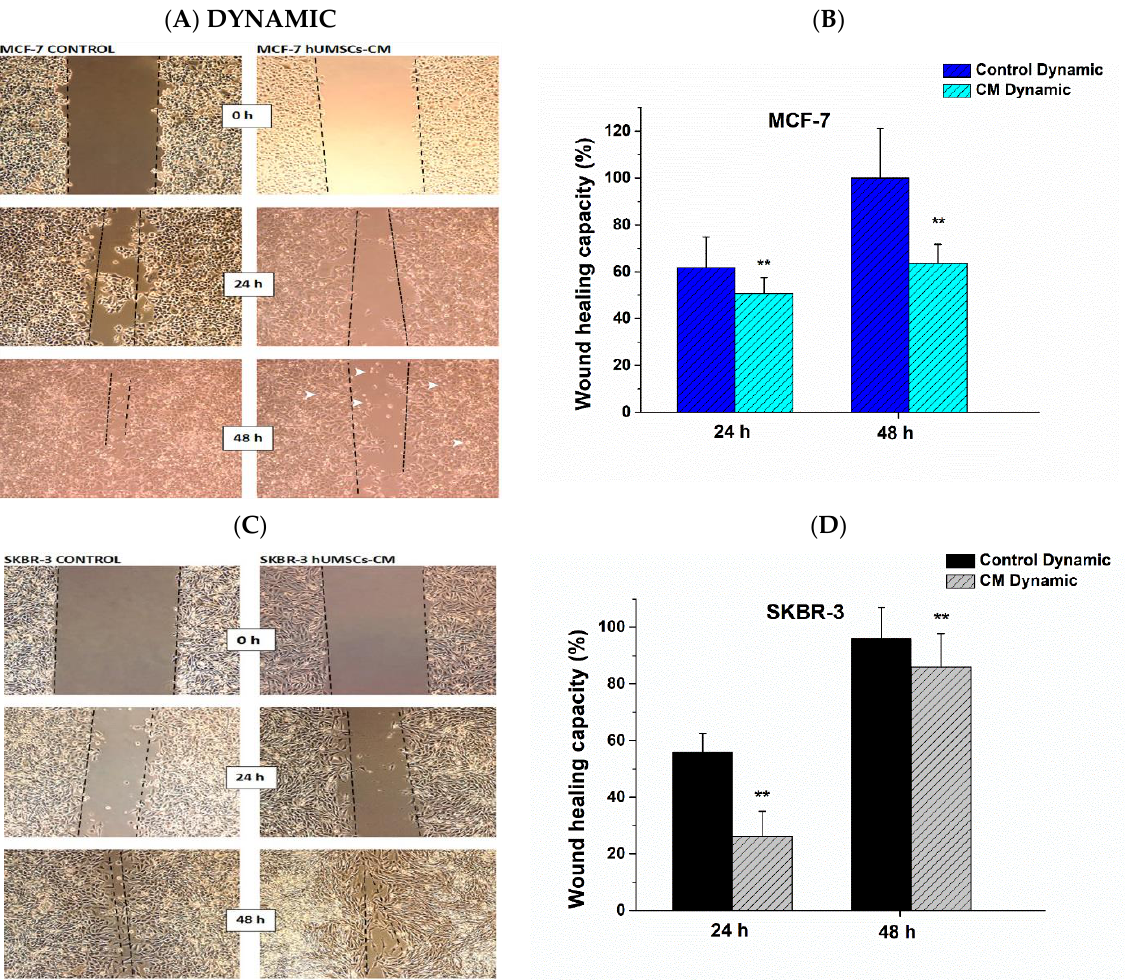
Figure 5. Quantitative analysis of the scratch-wound healing assay after 24 h and 48 h during dynamic conditions. The proliferation of the MCF-7 ( A , B ) and SKBR-3 cells ( C , D ) was examined in the absence and presence of hUMSCs-CM. Data represent mean values ± SD of three independent experiments were performed in both assays, * p < 0.05 and ** p < 0.01.